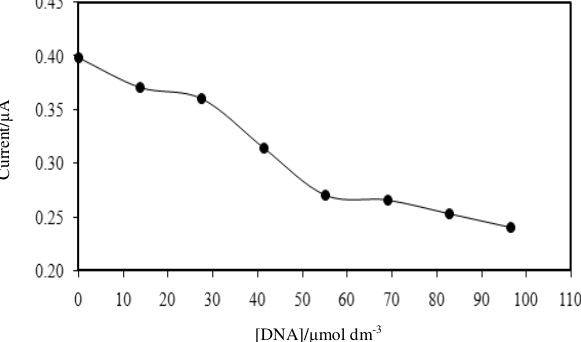
Figure 9. Dependence of peak current of MTX to DNA concentration. Conditions: C 0.0, 13.8, 27.6, 41.5, 55.3, 69.1, 82.9 and 96.7 µ mol L -1 , C